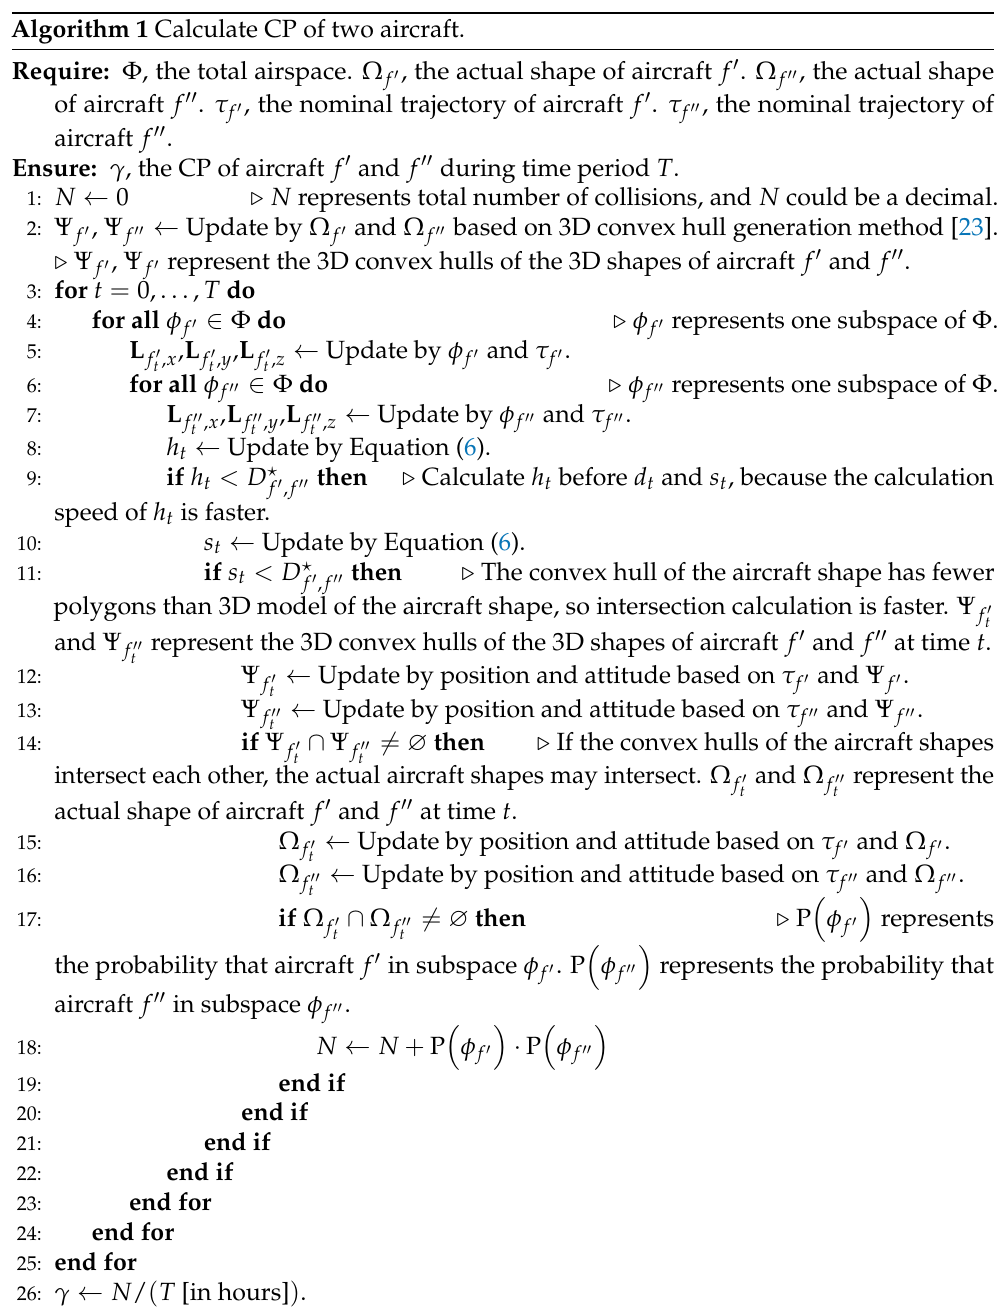
Algorithm 1 Calculate CP of two